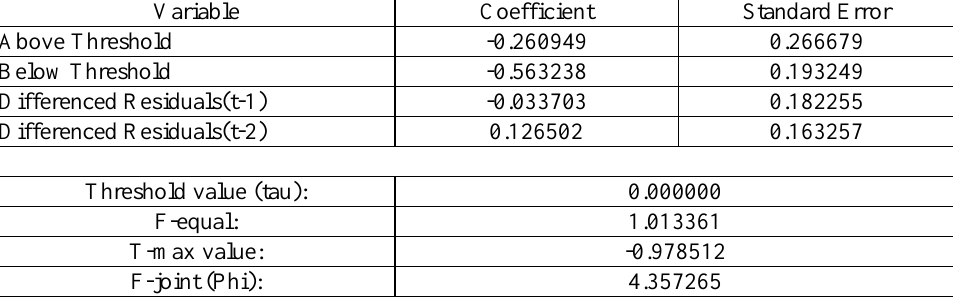
Table 5. Asymmetric cointegration using TAR model